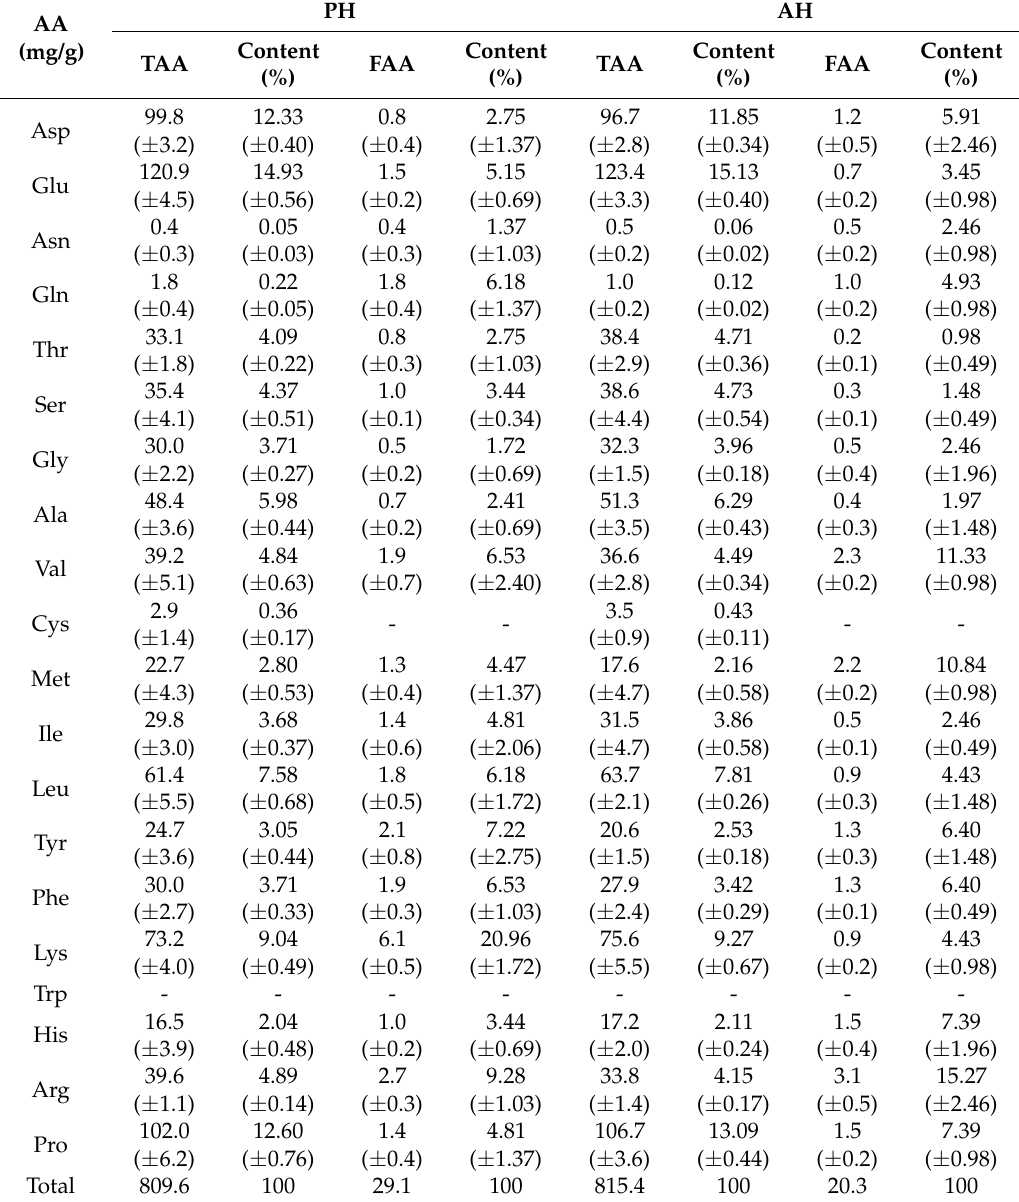
Table 3. TAA (total amino acid) and FAA (free amino acid) compositions and contents of PH and AH.